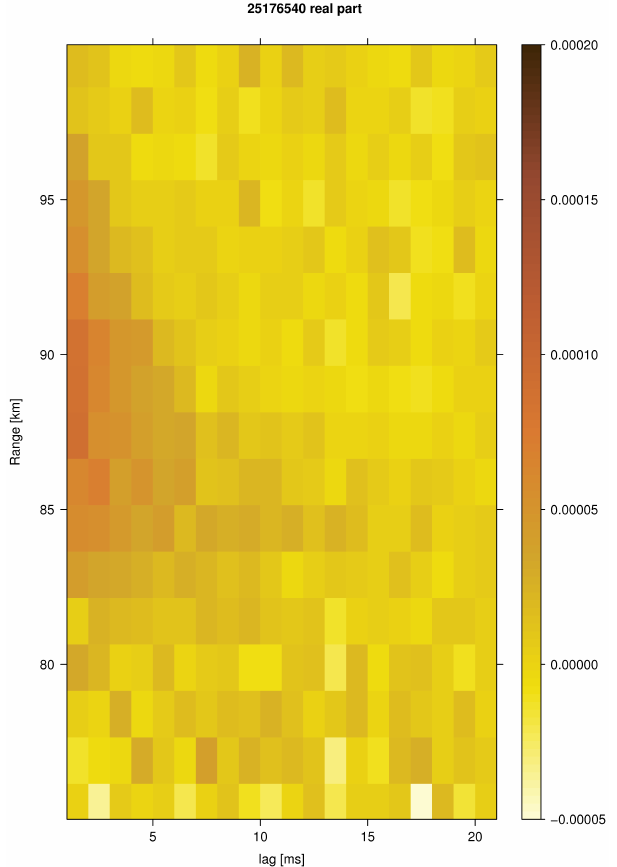
Fig. 8. Real parts of some D-region pulse-to-pulse lag profiles from experiment 2 19 October 2007 09:28UT. The time resolution is 1min, lag resolution 1ms and range resolution 1.5km. The ACF is in arbitrary units, but in same units as the ACF in Fig. 7.